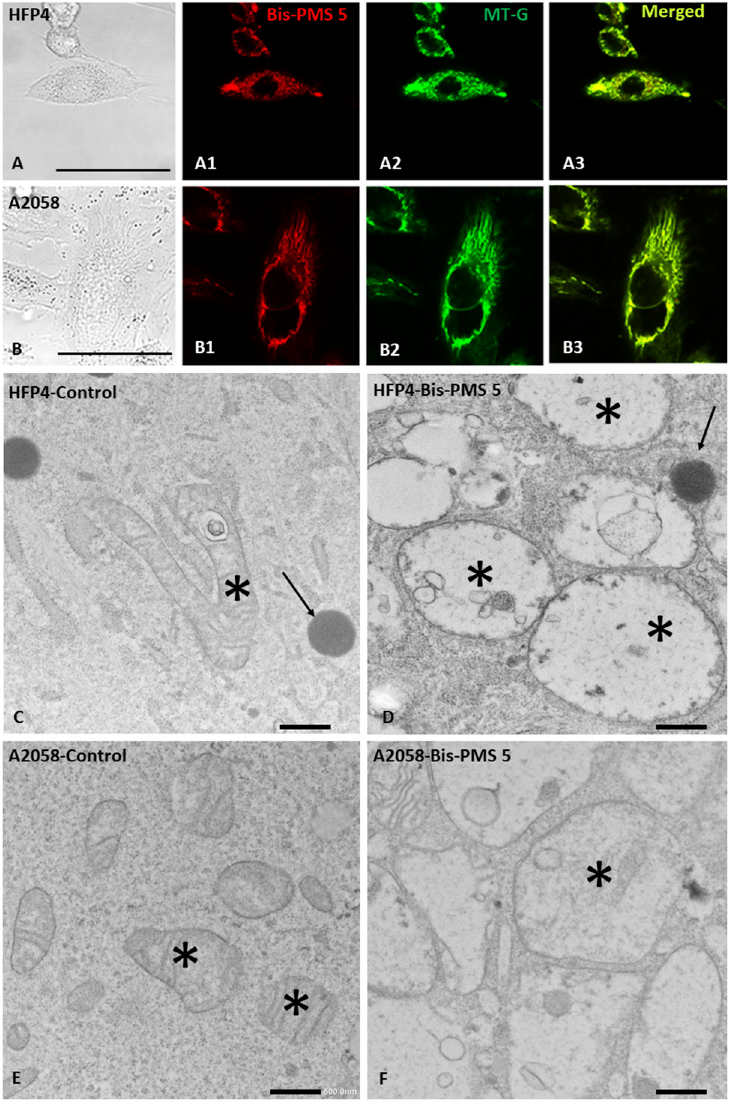
Figure 6. Influence of Bis ‐ PMS 5 on normal HFP4 fibroblast ( A , C , D ) and A2058 melanoma cells ( B , E , F ). Subcellular localization of Bis ‐ PMS 5 can be seen in the red channel ( λ ex = 630 nm, λ em = 650–670 nm, ( A1 , B1 )) and corresponds to the position of mitochondria stained with Mito ‐ Tracker (green channel: λ ex = 490 nm, λ em = 510–516 nm; ( A2 , B2 )). Colocalization is shown in ( A3 , B3 ) with a merged red and green signal. Electron microscopy ( C – F ) demonstrates the ultrastructure of normal fibroblasts ( C ), melanoma cells ( E ) and cells treated with Bis ‐ PMS 5 ( D , F ). Exposure of both cell types to 5 μ M of Bis ‐ PMS 5 for 2 h induced swelling of mitochondria with cristolysis ( D , F ). Asterisks mark mitochondria and arrows mark lipid droplets. Bar is 100 μ m ( A , B ) and 500 nm ( C – F ).